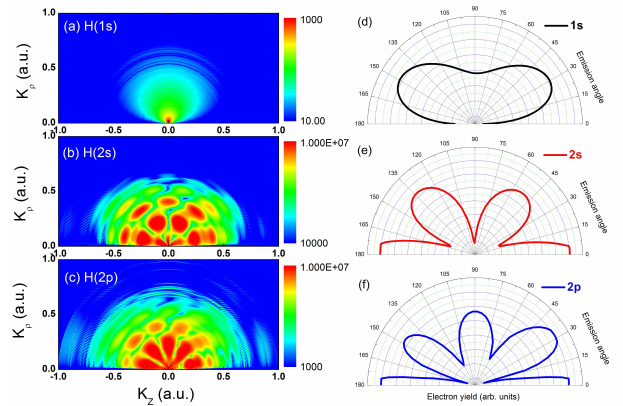
Figure 3. (Color online) PMDs for hydrogen initial states 1 s ( a ), 2 s ( b ) and 2 p ( c ) calculated by solving the TDSE for a 20 fs pulsed laser with 800 nm at 7.0 × 10 12 W/cm 2 . Polar plots of the PADs of near-threshold photoelectrons at the same laser parameters with the same initial states 1 s ( d ), 2 s ( e ) and 2 p ( f ), evaluated at kinetic energies corresponding to three-photon ionization of hydrogen via resonant